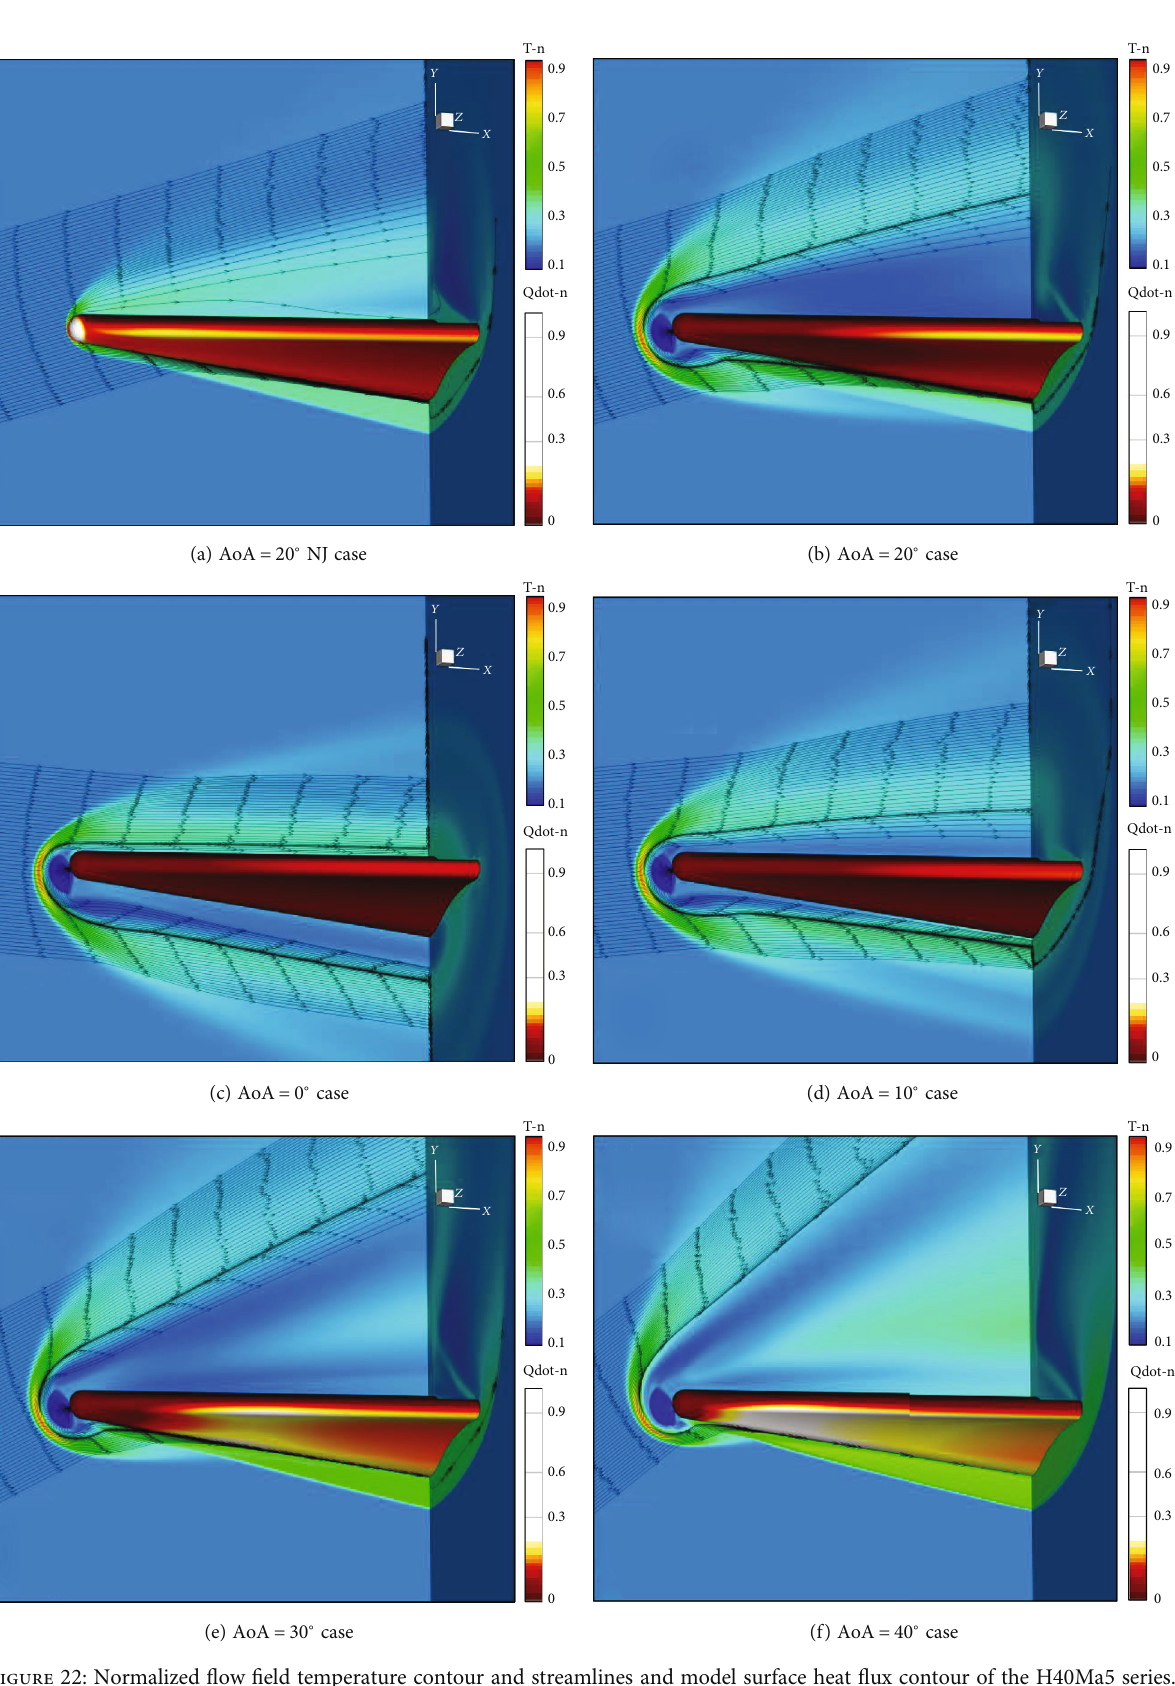
Figure 22: Normalized fl ow fi eld temperature contour and streamlines and model surface heat fl ux contour of the H40Ma5